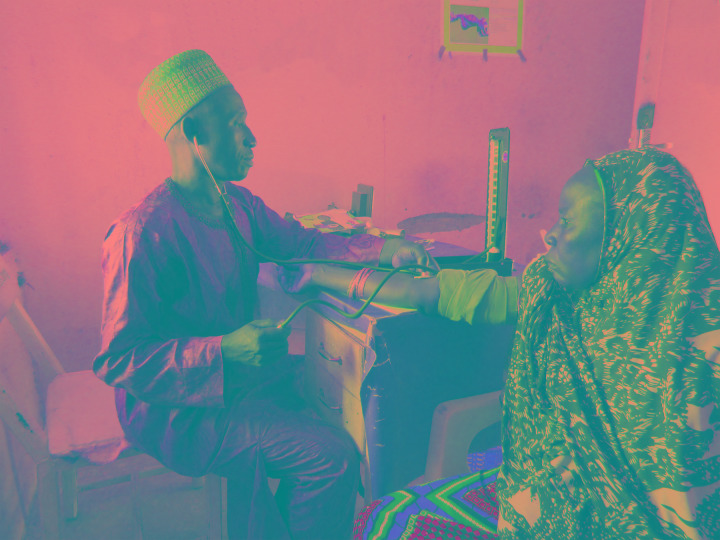
Photo: Healthcare provider measuring a pregnant woman’s blood pressure in Nigeria (from the collection of Karen Kirk, used with permission).